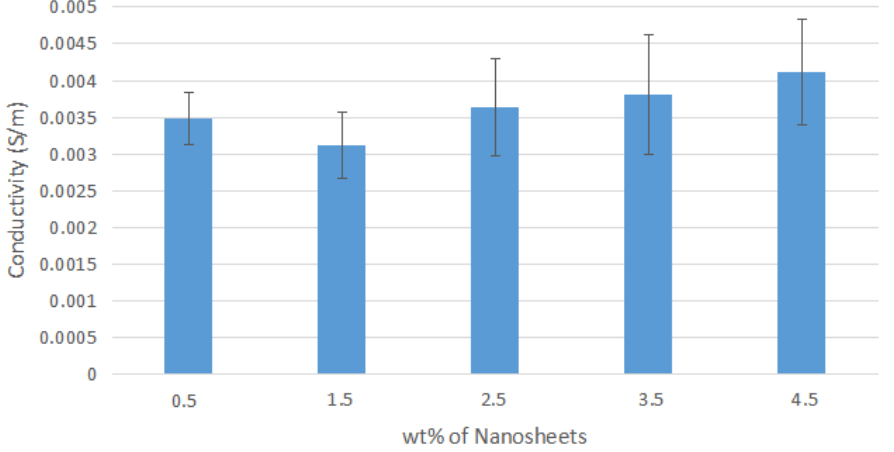
Figure A4. Average Conductivity of Nylon 610 Nanocomposites with Untreated Nanosheets.